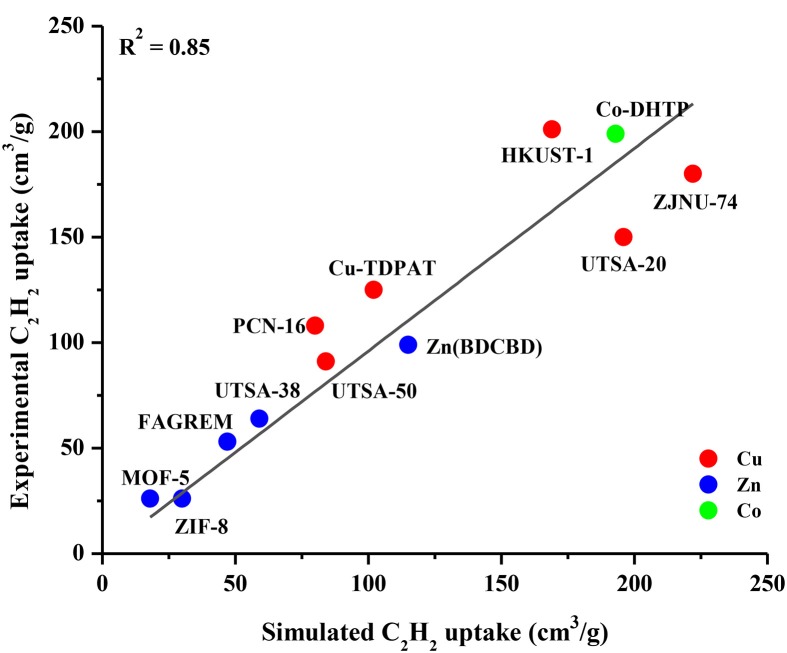
Comparison of experimental and simulated C2H2 uptakes of MOFs at 1 bar, 298 K.